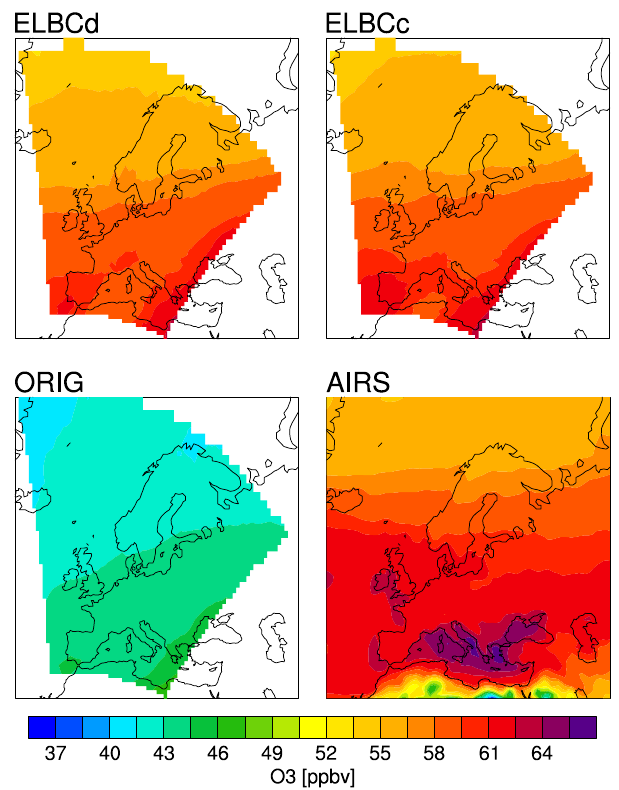
Figure 15. Same as Fig. 14, but for O 3